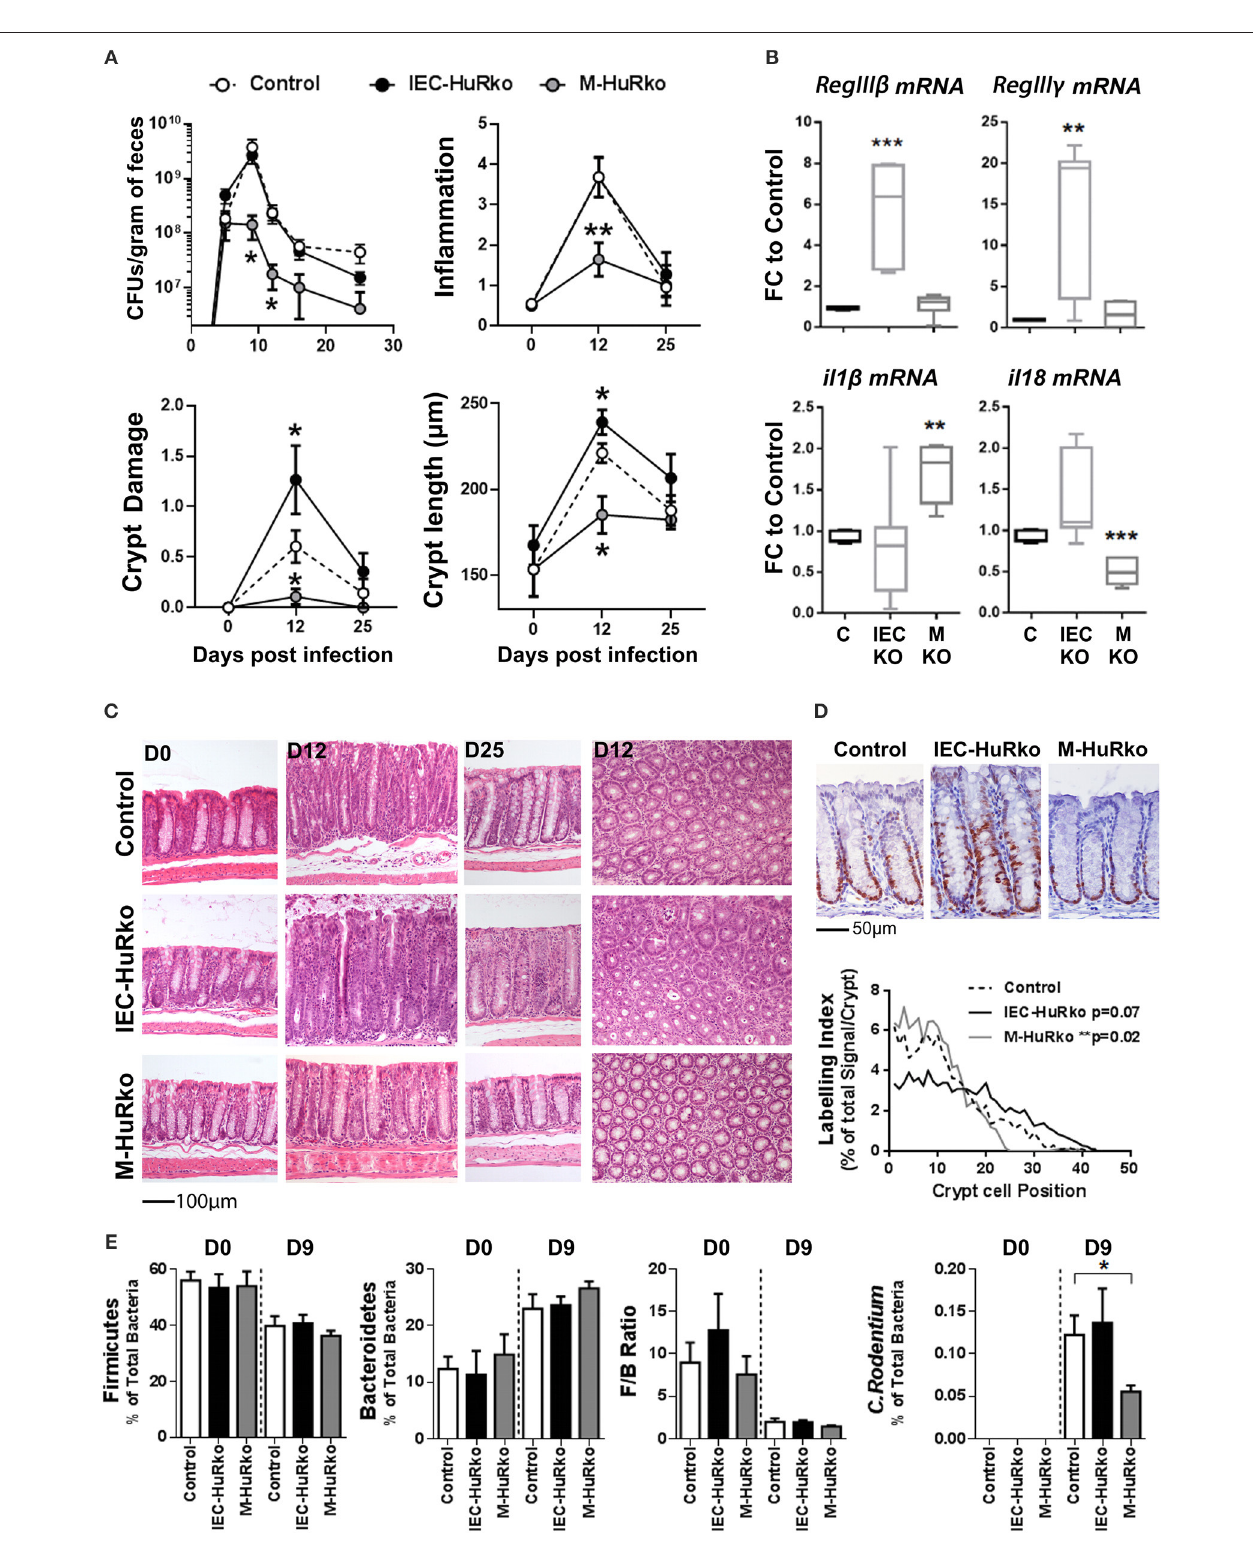
FIGURE 3 | Differential susceptibility of IEC-HuRko and M-HuRko mice to C. rodentium infection. (A) (upper left) Fecal bacterial counts in mice orally infected with C. rodentium . ( n = 16/group). Histological score of inflammation (upper right) and crypt damage (lower left) of uninfected (day 0) and infected mice (days 12 and 25). day